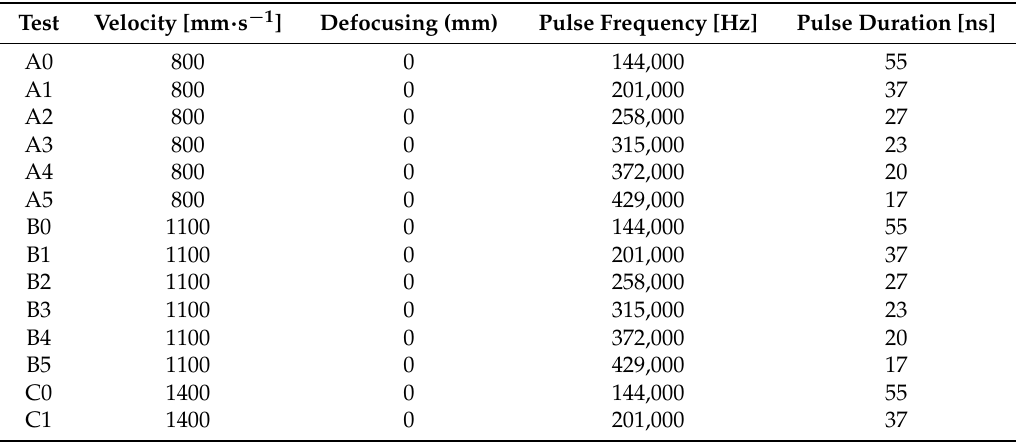
LBM tests are named with upper case letters. Table A1. LBM process